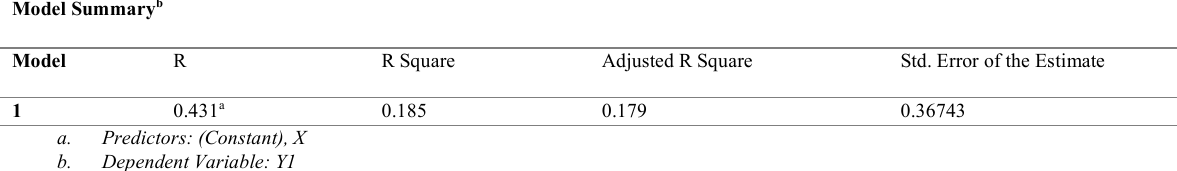
Table 6: Coefficient of Determination of The Effect of Job Crafting on Work